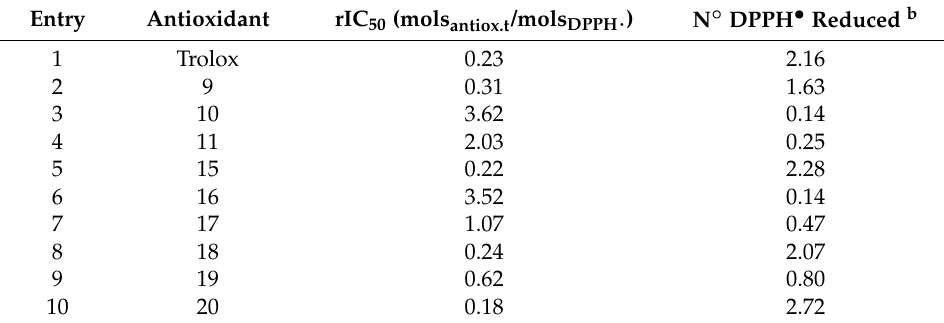
Table 3. Antioxidant capacity of compounds 9 – 11 and 15 – 20 towards DPPH • in methanol a .